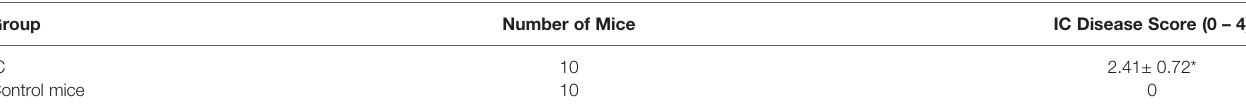
The UB disease score was determined by histopathological examination at the end of the experiment. UBs were fi xed, sectioned at 6 µm, and stained with hematoxylin and eosin, examined microscopicallyat 10Xand 40Xmagni fi cation,and scored fortheseverity of IC.Thestudies were performed in triplicate and thedatarepresent themean andpercent change ± SD. Differences between IC and naïve groups were considered signi fi cant when p < 0.01